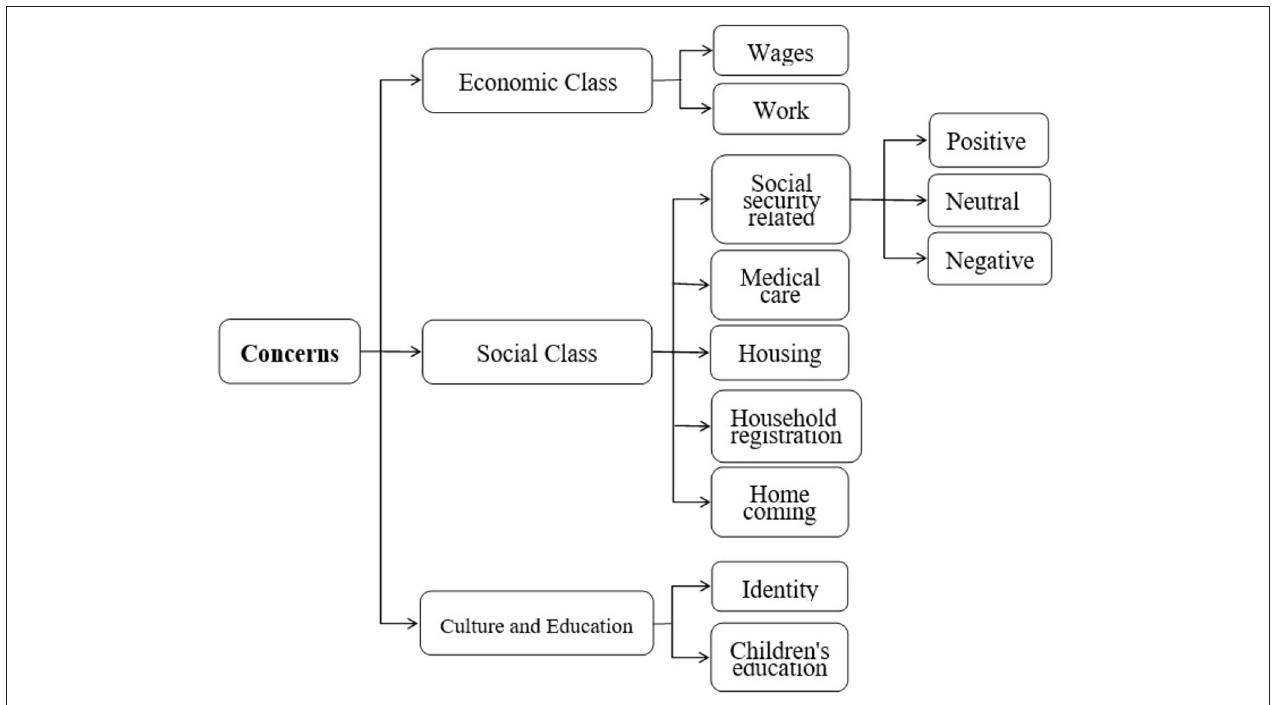
FIGURE 2 | Classification framework of migrant works’